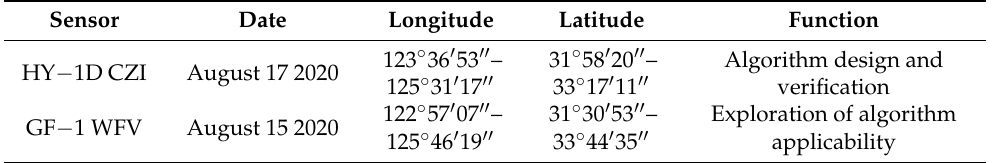
Table 2. Detailed information of HY − 1D CZI and GF − 1 WFV images. Sensor Date Longitude Latitude